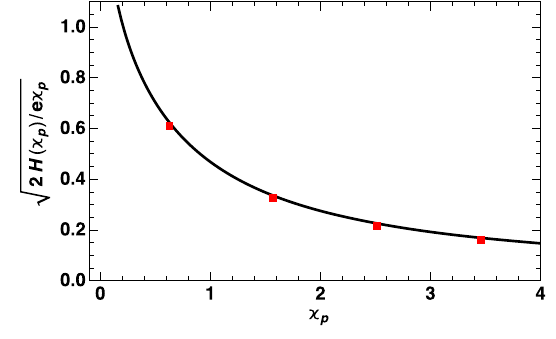
p ffiffiffiffiffiffiffiffiffiffiffiffiffiffiffiffiffiffiffiffiffiffiffiffiffi 2 H ð ϰ = e ϰ (solid curve). The p Þ p